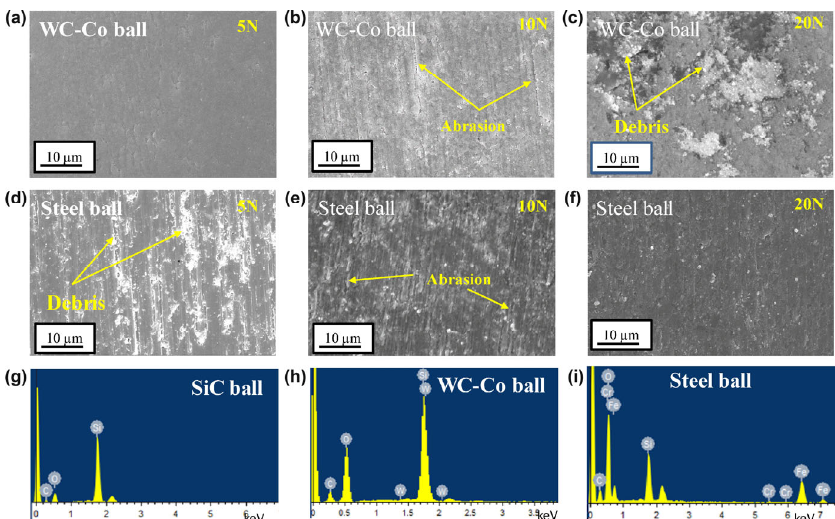
Fig. 9 SEM images of worn surfaces of SiC ceramics against WC-Co and steel counterbodies at 5 N, 10 N and 20 N load. EDS analysis of worn surface at 20 N against WC-Co and steel ball (g–i).